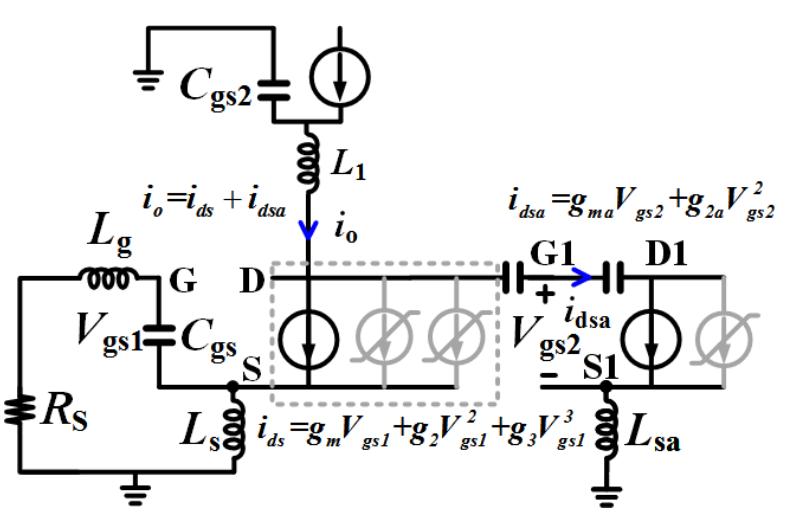
Figure 9. Equivalent circuit model for calculation of